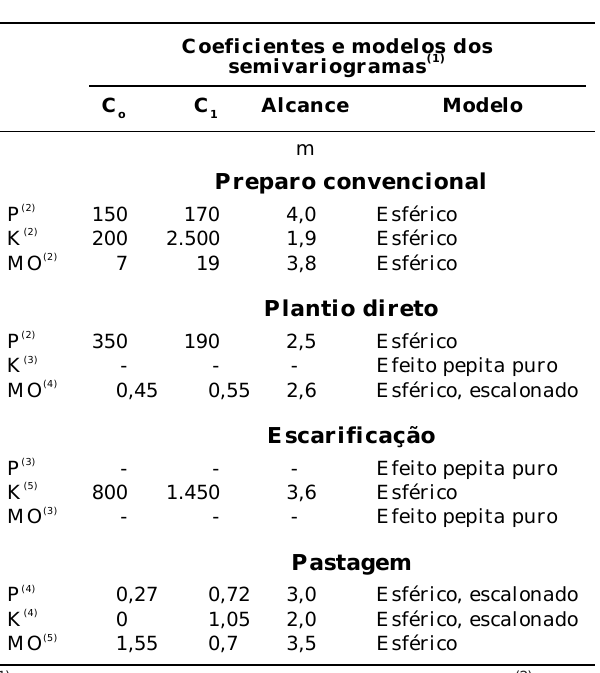
Quadro 3. Coeficientes e modelos dos semivariogramas ajustados aos dados experimentais em Eldorado do Sul